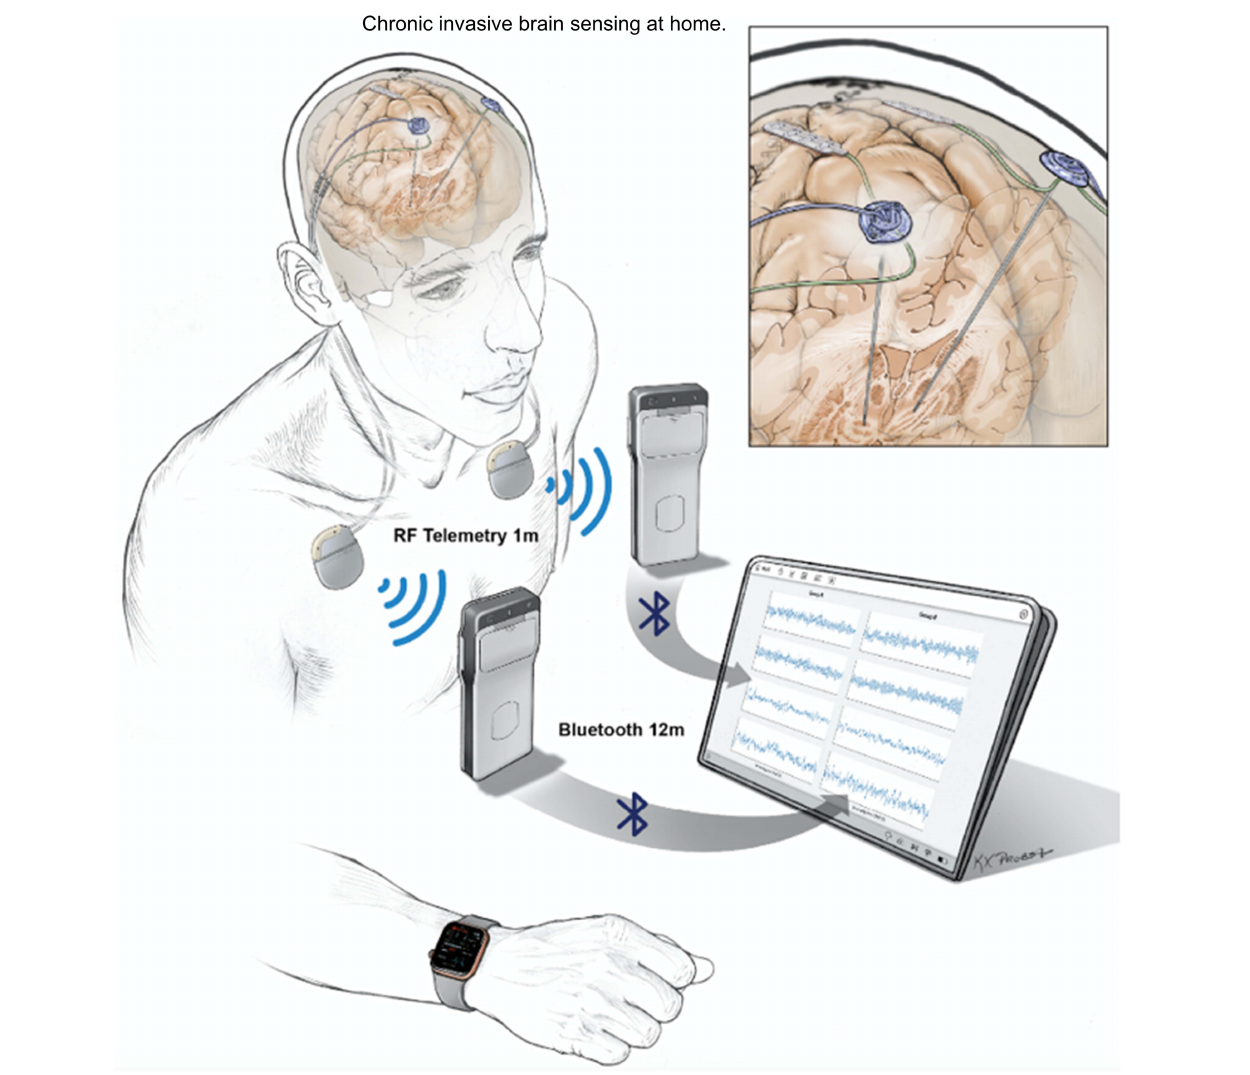
FIGURE 6 | UCSF protocol for data streaming from Summit RC + S. Quadripolar leads were placed bilaterally into the subthalamic nuclei and over the motor cortex. Leads were connected to the ipsilateral Summit RC + S neural interfaces. Each RC + S device wirelessly communicates with a pocket-sized relay device, usually worn on the patient. The relay devices transmit by Bluetooth to a single small Windows-based tablet at a distance of up to 12 m, allowing sensing of local field potentials from up to four bipolar electrode pairs for up to 30 h per device, before recharge is needed. Data from a wristwatch-style actigraphy monitor (Parkinson’s Kinetograph, Global Kinetics) are synchronized off-line with neural recordings to facilitate brain-behavior